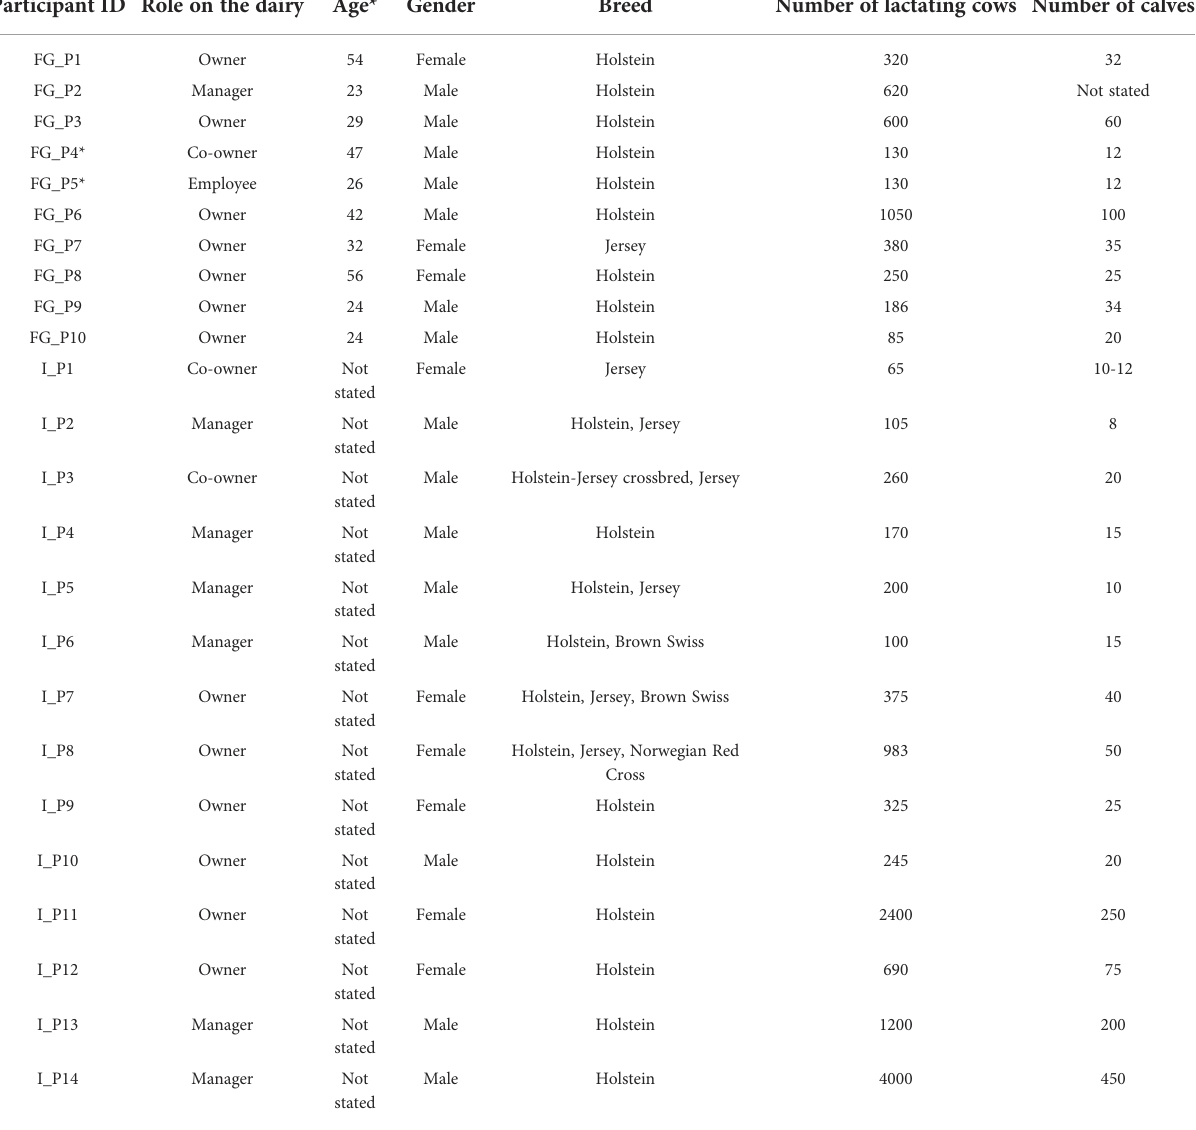
TABLE 1 Focus group (n = 10) and interview (n = 14) participant details and farm demographics for dairy producers included in this study. Participant ID Role on the dairy Age*